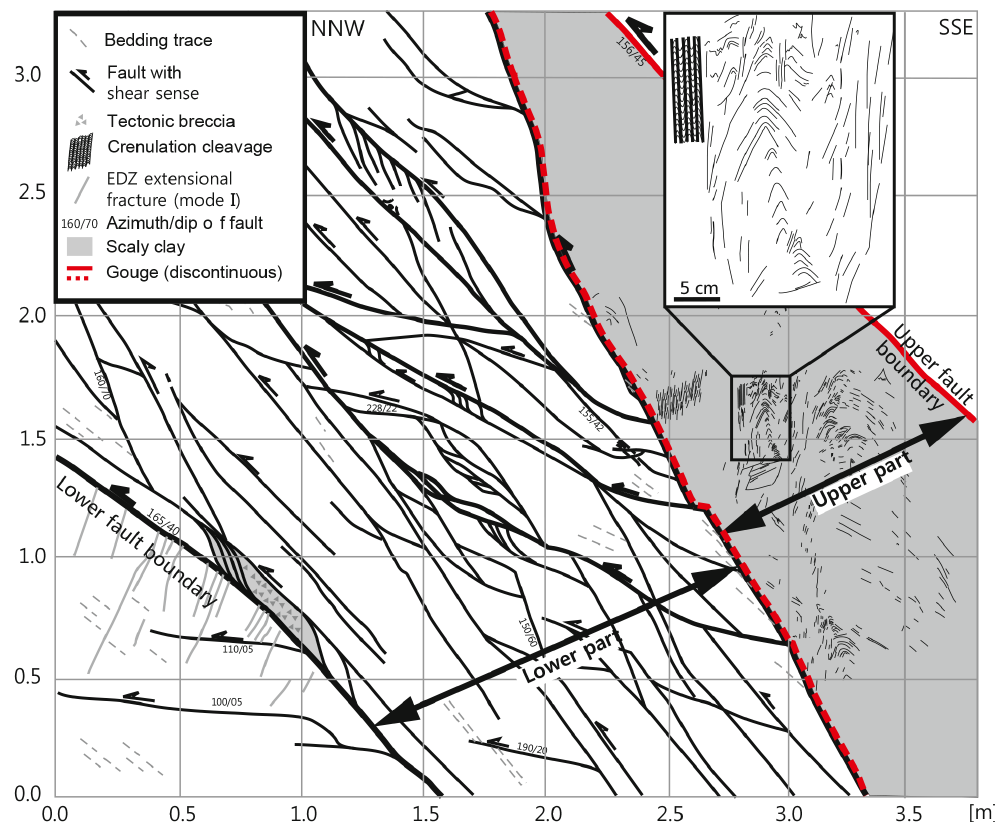
Figure 2. Small-scale map of the Main Fault in Gallery 08, viewing direction ENE; see Fig. 1 for the location (modified after Nussbaum et al.,